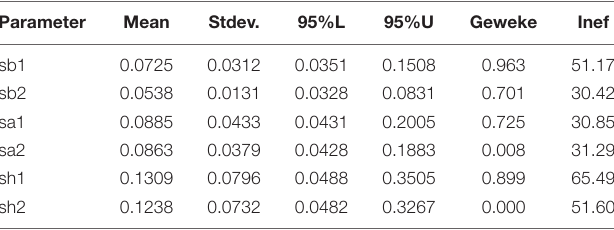
TABLE 1 | Estimation results for selected parameters in the TVP-VAR model. Parameter Mean Stdev. 95%L